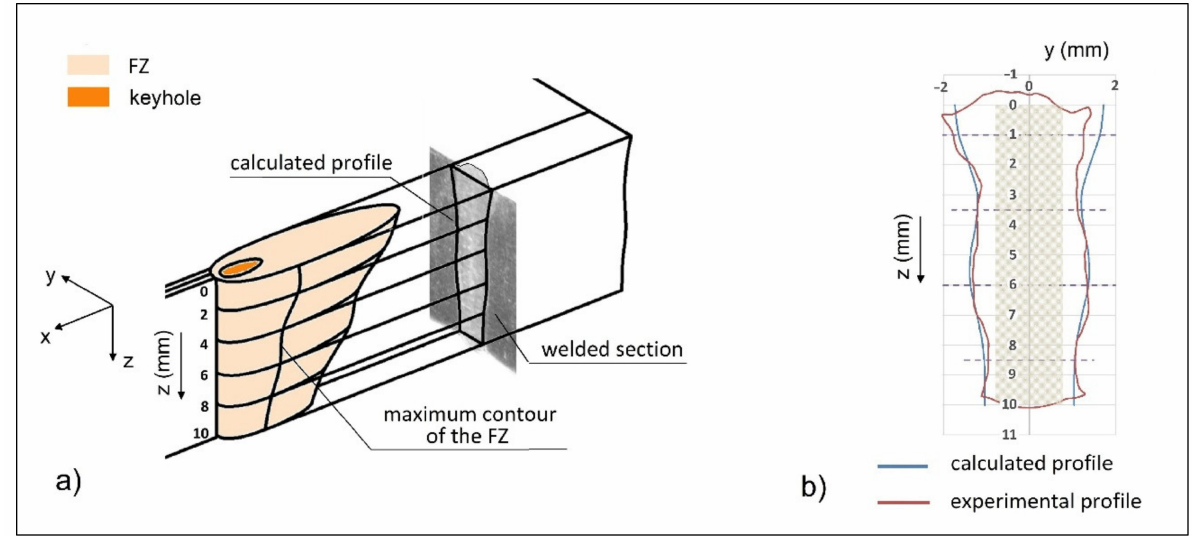
Figure 3. FZ modelling: ( a ) 3D model of the melt pool and projection of the profile on the cross section; ( b ) Comparison between the calculated and experimental profiles (the grey rectangle indicates the position of the four consumable